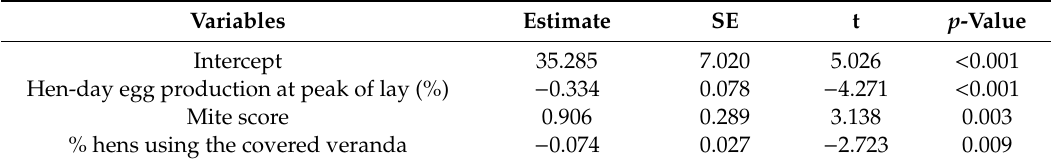
Table 6. Linear regression model for mortality rate in laying hens in % (n = 56).